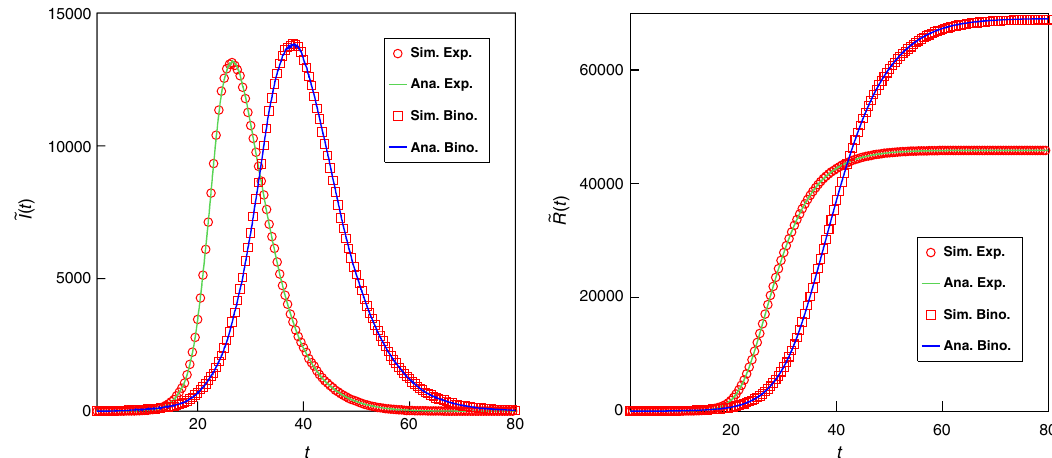
FIG. 5. Number of infectious (left panel) and removed individuals (right panel) as a function of time for the binomial ( z 1 ¼ 5 , 0 : 127 71 , and (cid:1) 0 : 25 ) and exponential ( (cid:5) ¼ 4 ) networks. The solid curves come from the evaluation of Eqs. (20) and (21), (cid:1) i ¼ r ¼ and the symbols come from the direct counting of the infectious and removed individuals at any given time for a specific realization of the